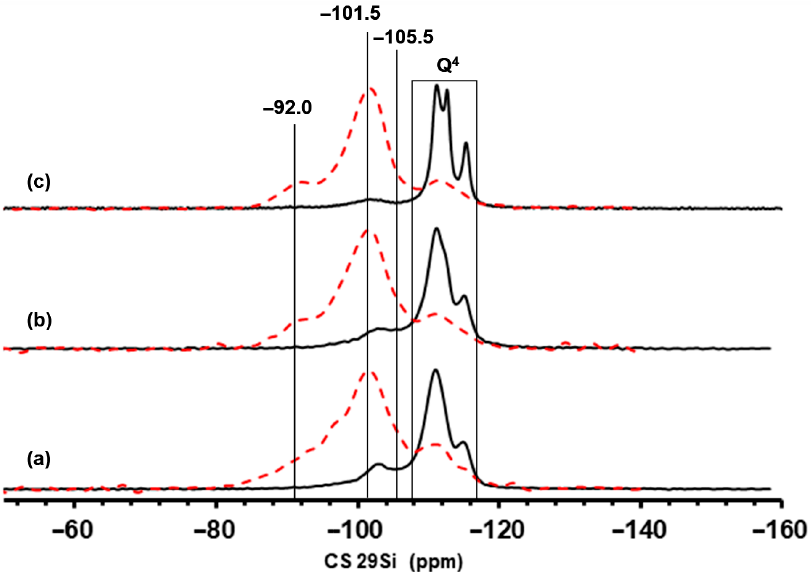
Figure 3. 29 Si MAS NMR spectra of ZnAlBEA ( a ), ZnAlSiBEA ( b ), and ZnSiBEA ( c ). Black curves are direct polarization (DP) spectra and red dotted curves are cross polarization (CP) spectra.